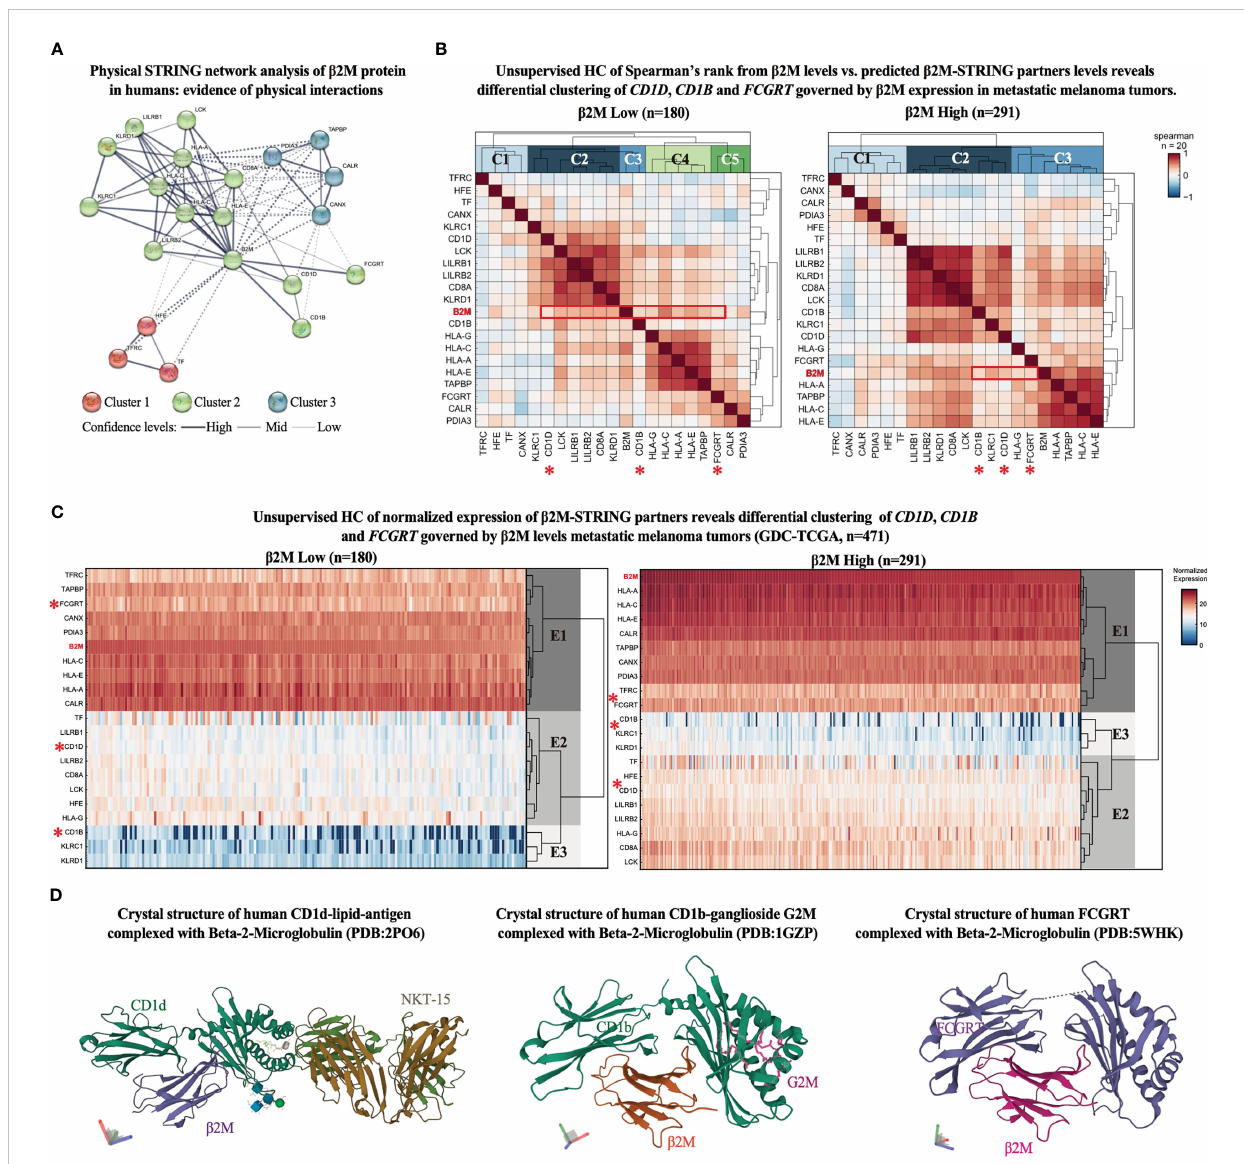
FIGURE 1 b 2M expression associates with proteins responsible for antigen presentation of non-self-glycolipids in metastatic melanoma. (A) STRING network representation of human b 2M-associated proteins. Edges indicate that the proteins are part of a physical complex distributed in the subnetwork. Line thickness indicates the strength of data support. The minimum required interaction score was set at 0.400. The k-means clustering method was used for network distribution to three clusters. Dotted lines represent edges between clusters. (B) Unsupervised hierarchical clustering (HC) of Spearman ’ s correlation scores between b 2M expression levels and STRING-predicted b 2M physical partners expression levels from metastatic melanoma samples from GDC-TCGA-SKCM study. Heatmaps represent positive correlation (up to 1, red), low correlation (close to 0, white), and negative correlation (up to -1, blue) scores in patients with low (left) and high (right) b 2M expression. Expression cutoff: median of b 2M expression in the cohort. (C) Unsupervised hierarchical clustering (HC) of STRING-predicted b 2M physical partners. Columns are clustered using Euclidian/Ward metric/method. Paired color maps indicate raw expression values. (D) Crystal structure of b 2M conjugated with CD1d (PDB: 2PO6), CD1b (PDB: 1GZP), and FCGRT (PDB: 5WHK)